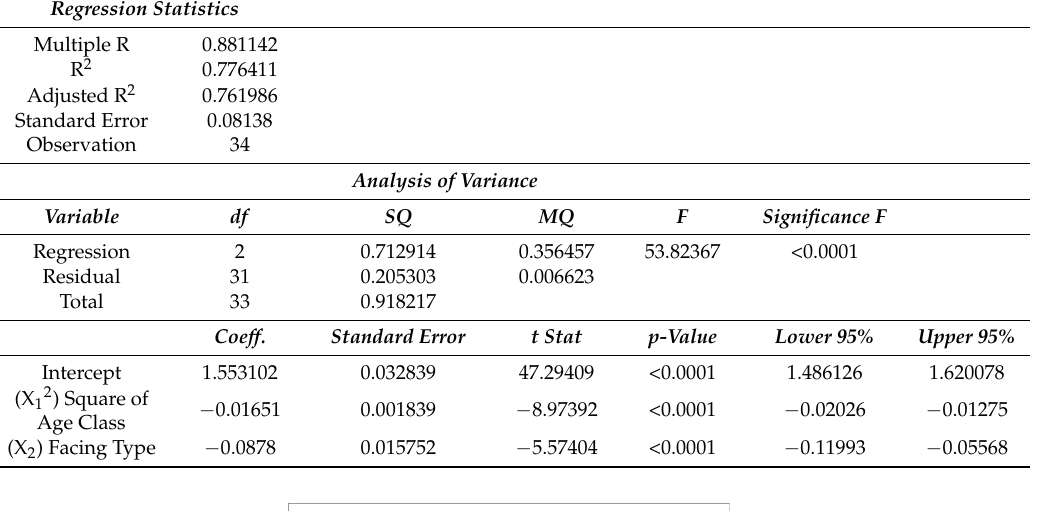
Table 4. Global model: regression statistics and ANOVA.